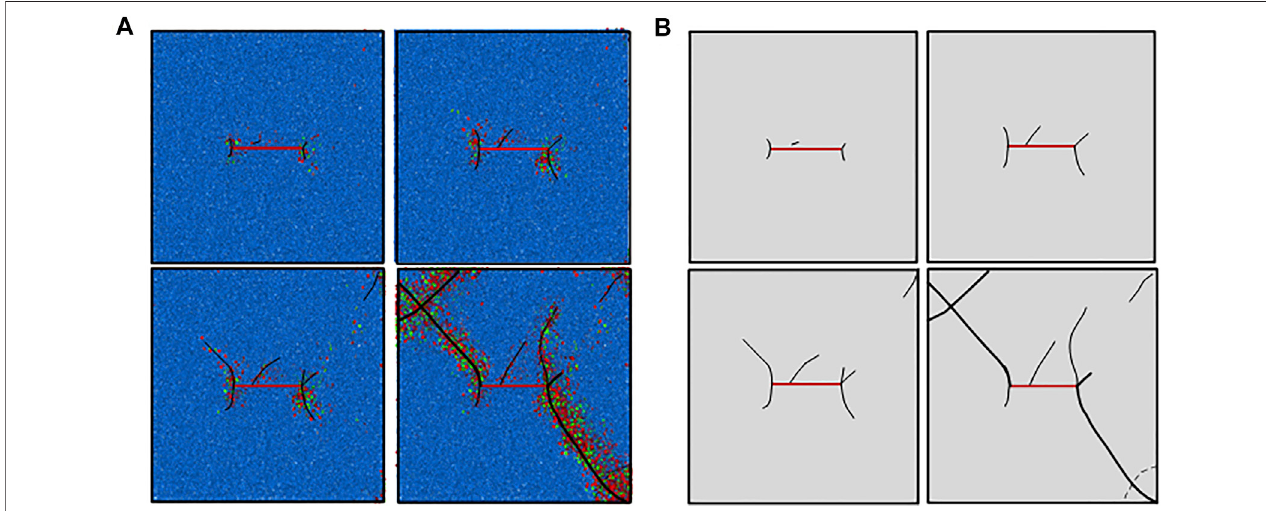
FIGURE 7 | Sample simulation and sketch under loading plan A. (A) Simulation diagram of loading plan A; (B) sketch of the fracture.